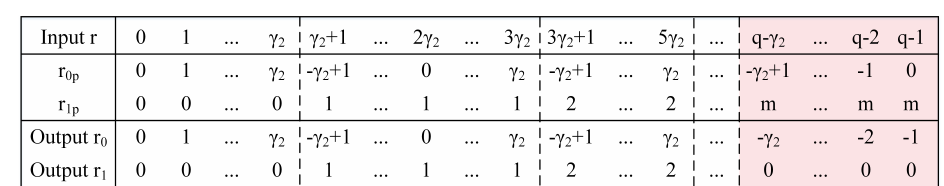
Figure 12: Data correspondence for Decompose. Pink shading represents the border case.